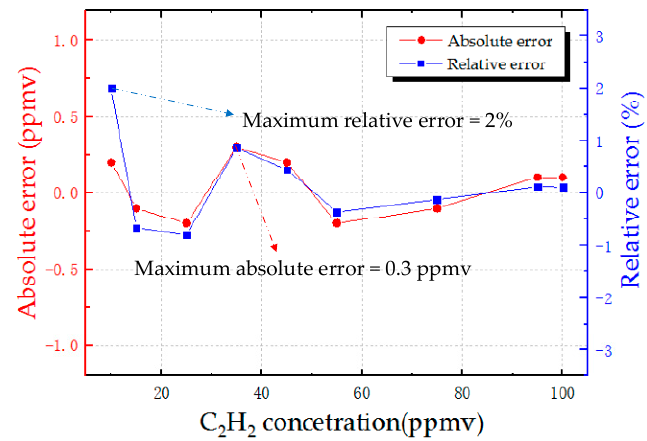
Figure 8. Detection error of the system on nine C 2 H 2 samples with concentrations of 10, 15, 25, 35, 45, 55, 75, 95, and 100 ppmv.